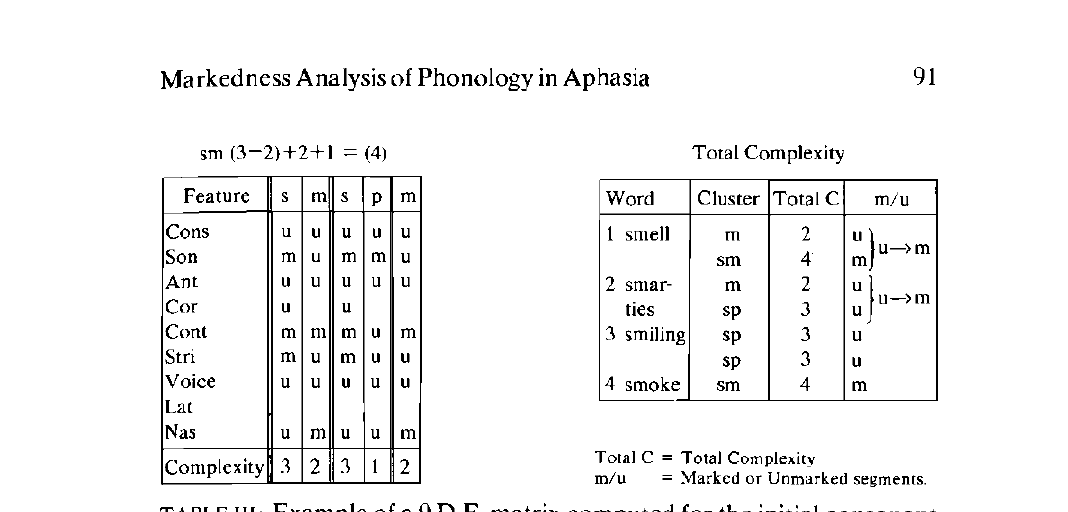
TABLE III: Example of a 9 D.F. matrix computed for the initial consonant cluster /sm/, and its various